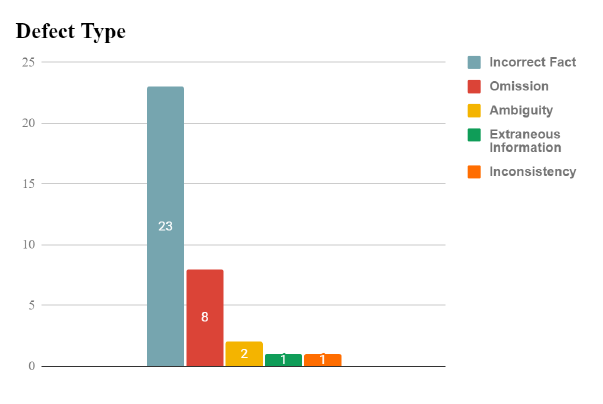
Figure 9. Number of defects